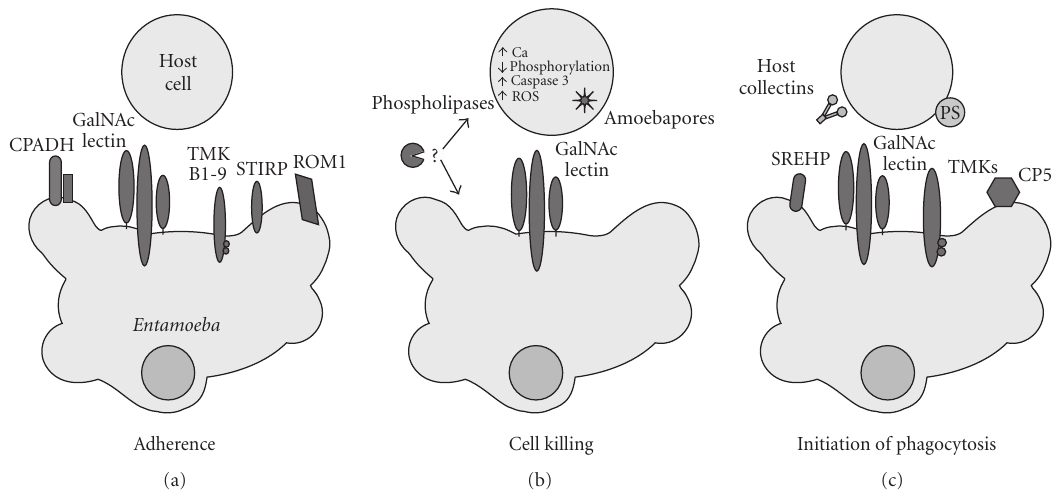
Figure 1: Sequential model of cell killing and phagocytosis by Entamoeba histolytica . Adherence, cell killing, and initiation of phagocytosis leading to engulfment of host cells are depicted from left to right. Abbreviations: cysteine protease adhesin (CPADH), transmembrane kinase (TMK), serine-threonine-isoleucine rich protein (STIRP), reactive oxygen species (ROS), serine-rich Entamoeba histolytica protein (SREHP), cysteine protease 5 (CP5), and phosphatidylserine